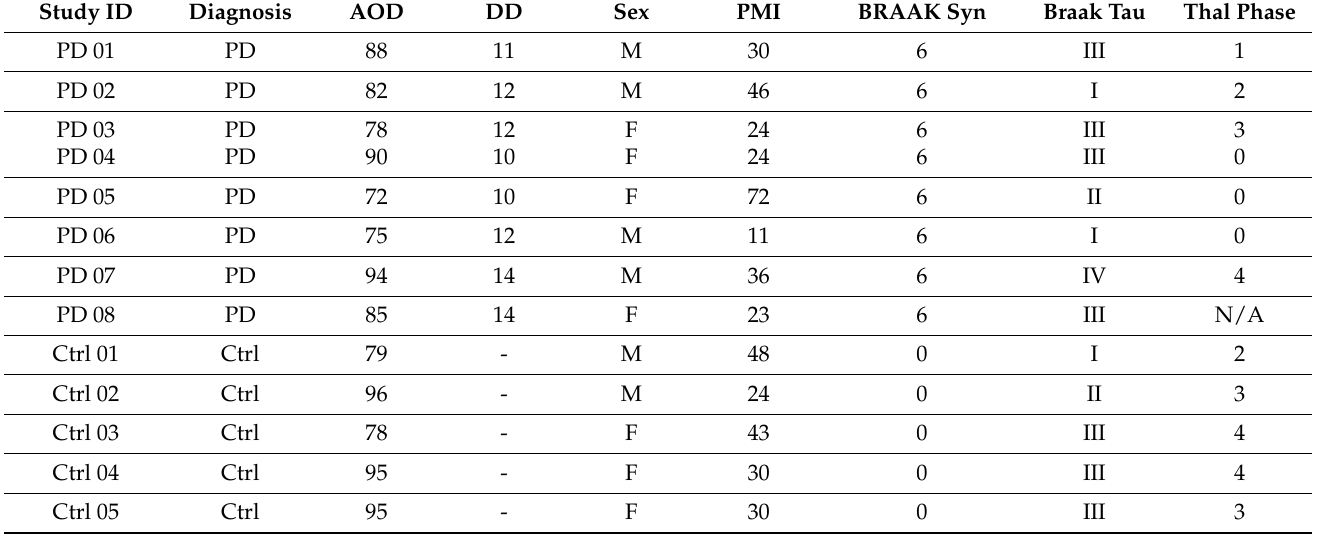
Table 1. Demographic data of included